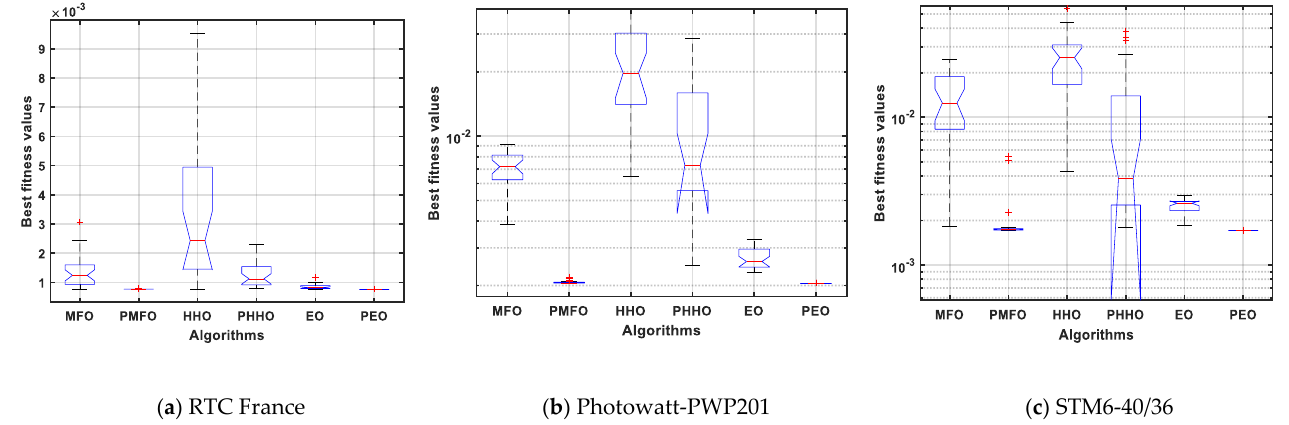
Figure 11. Comparison among algorithms based on Boxplot.